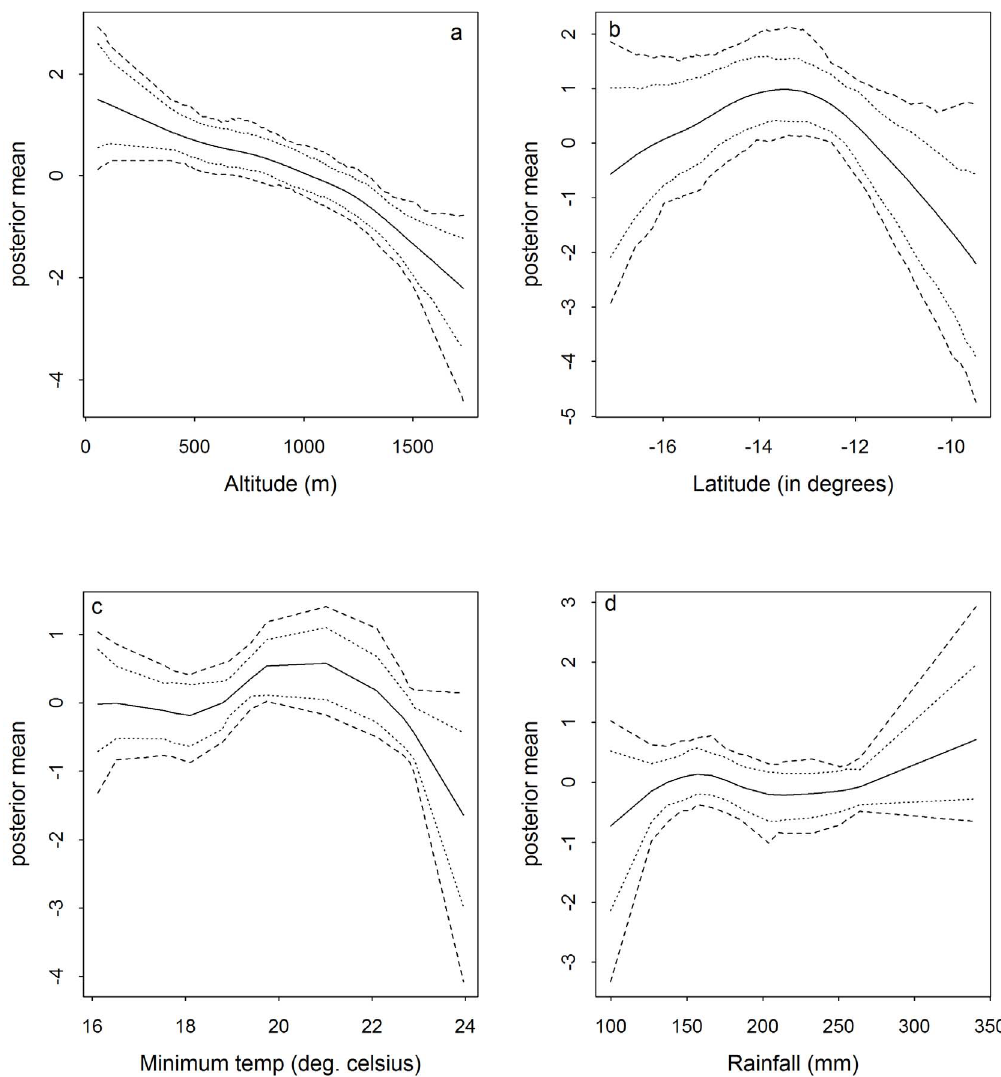
Figure 3. Non linear effect of different continuous covariates on malaria risk (a) altitude (b) latitude (c) minimum temperature (d) rainfall. Plots based on model estimates from the multivariate spatial model with splines (model M). The inner and outer dotted lines are the 80% and 95% CI respectively. The solid middle line is the posterior mean.